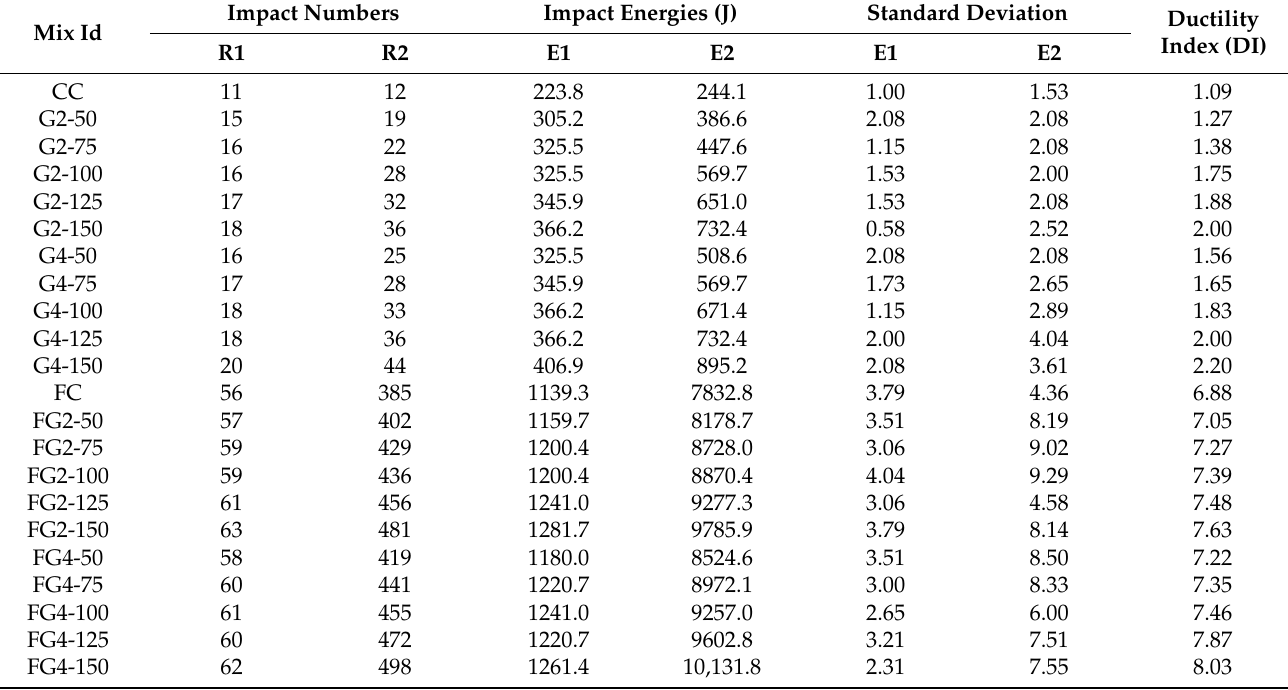
Table 2. Impact test